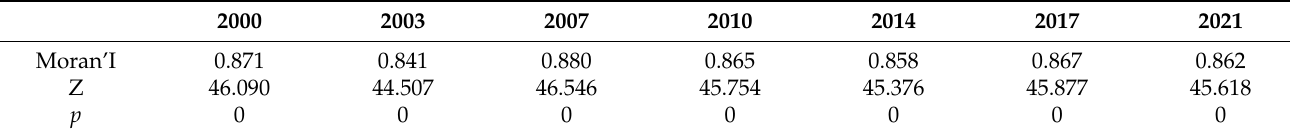
Table 9. Global Moran Test of RSEI in the Weihe River Basin.